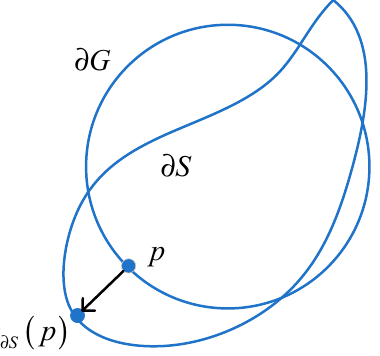
Figure 10. Schematic of the boundary integral of Dist ( ∂ G, ∂ S ) .